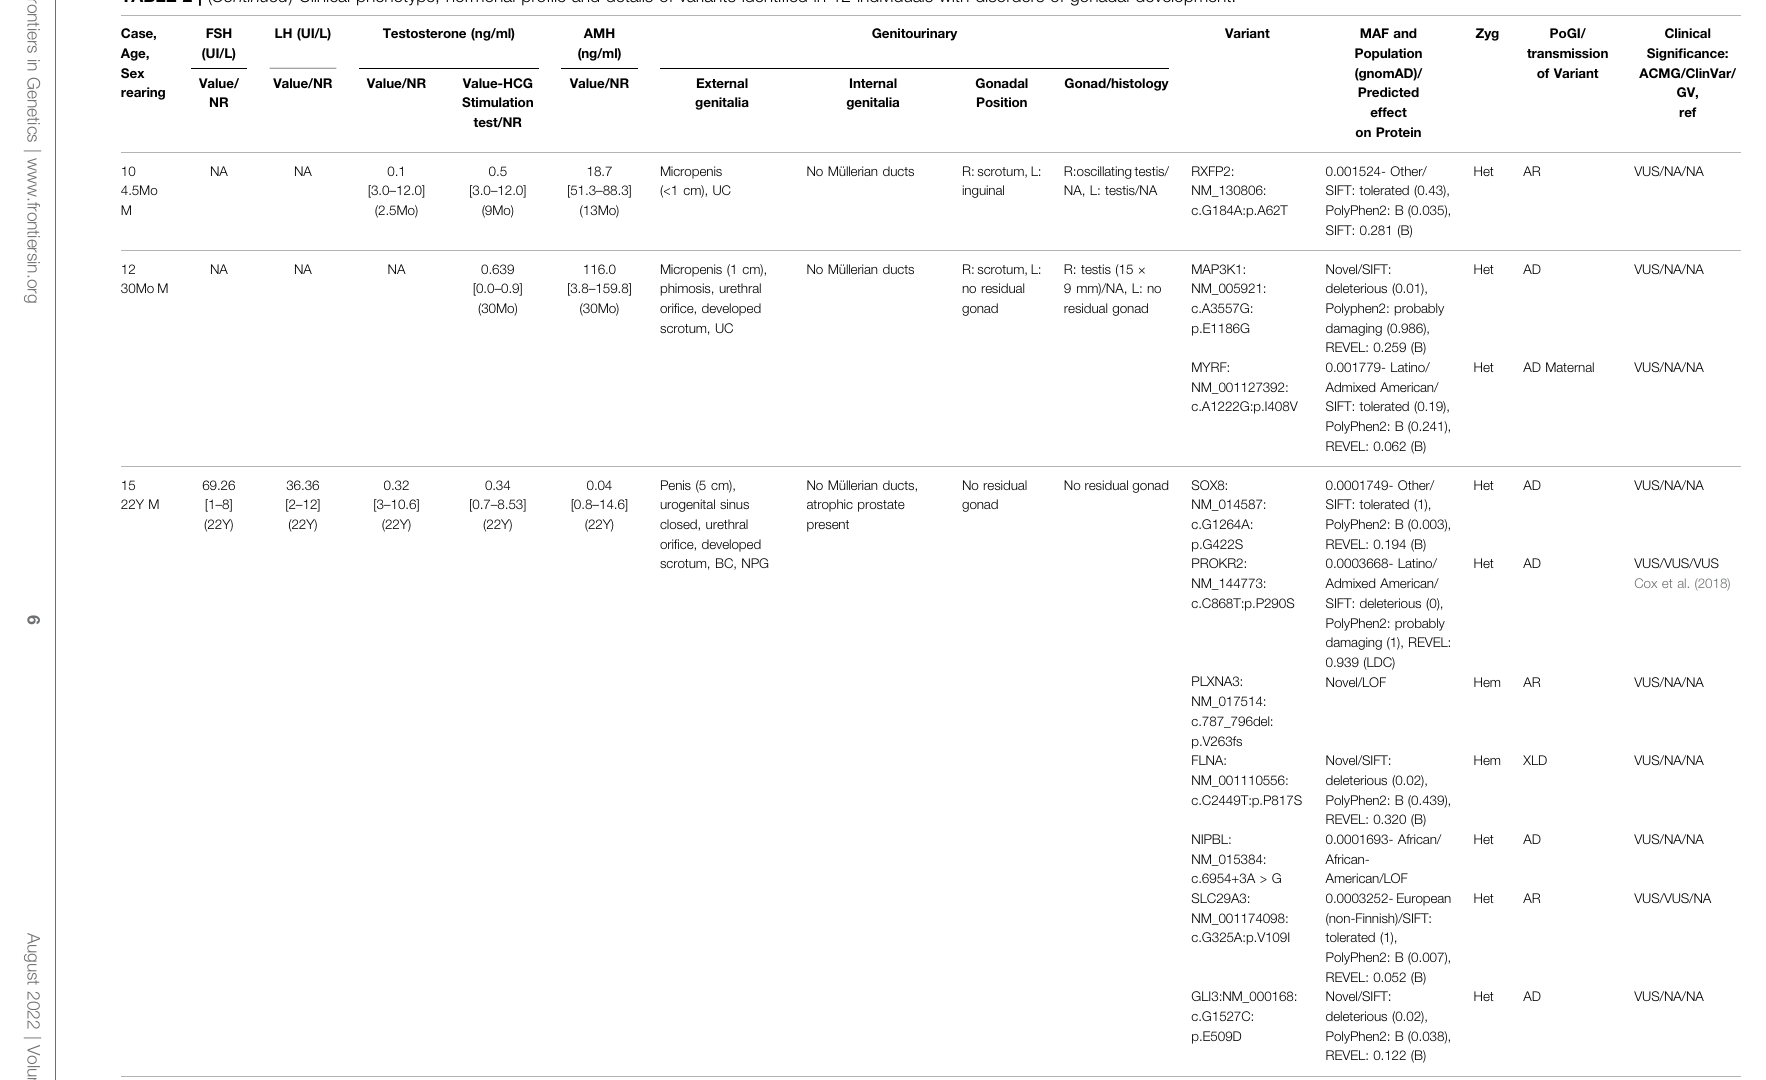
TABLE 2 | ( Continued ) Clinical phenotype, hormonal pro fi le and details of variants identi fi ed in 12 individuals with disorders of gonadal